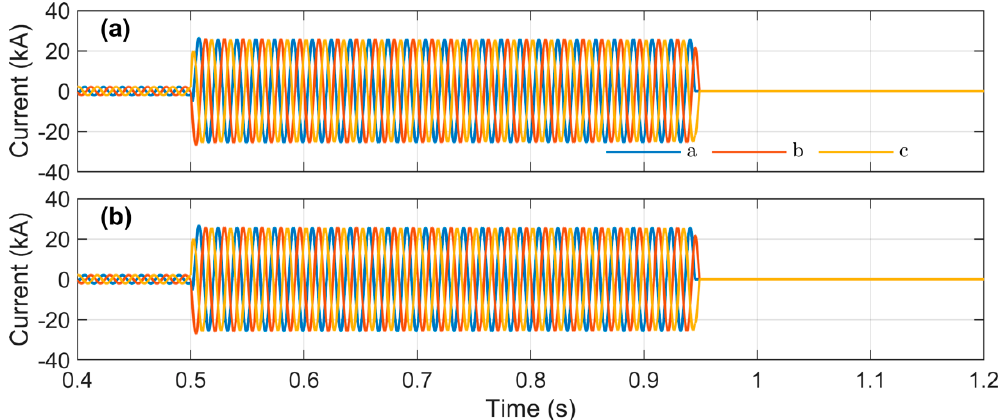
13 of 16 Figure 24. Relay trip signals in case DCR and DOCR fail: ( a ) relays in HTS 1 ; ( b ) relays in HTS 2 . Figure 25. Operation of circuit breakers in case DCR and DOCR fail. Three-phase currents of two HTS cables are illustrated in Figure 26 and the power flows through two HTS cables are shown in Figure 27. The three-phase-to-ground fault at 0.5 s causes the rapid increase of current and power, in which the peak fault current is 27 kA and peak power is 520 MW. The fault is completely isolated by opening CB 1 and CB 4 at 0.94 s, resulting in the reduction of current